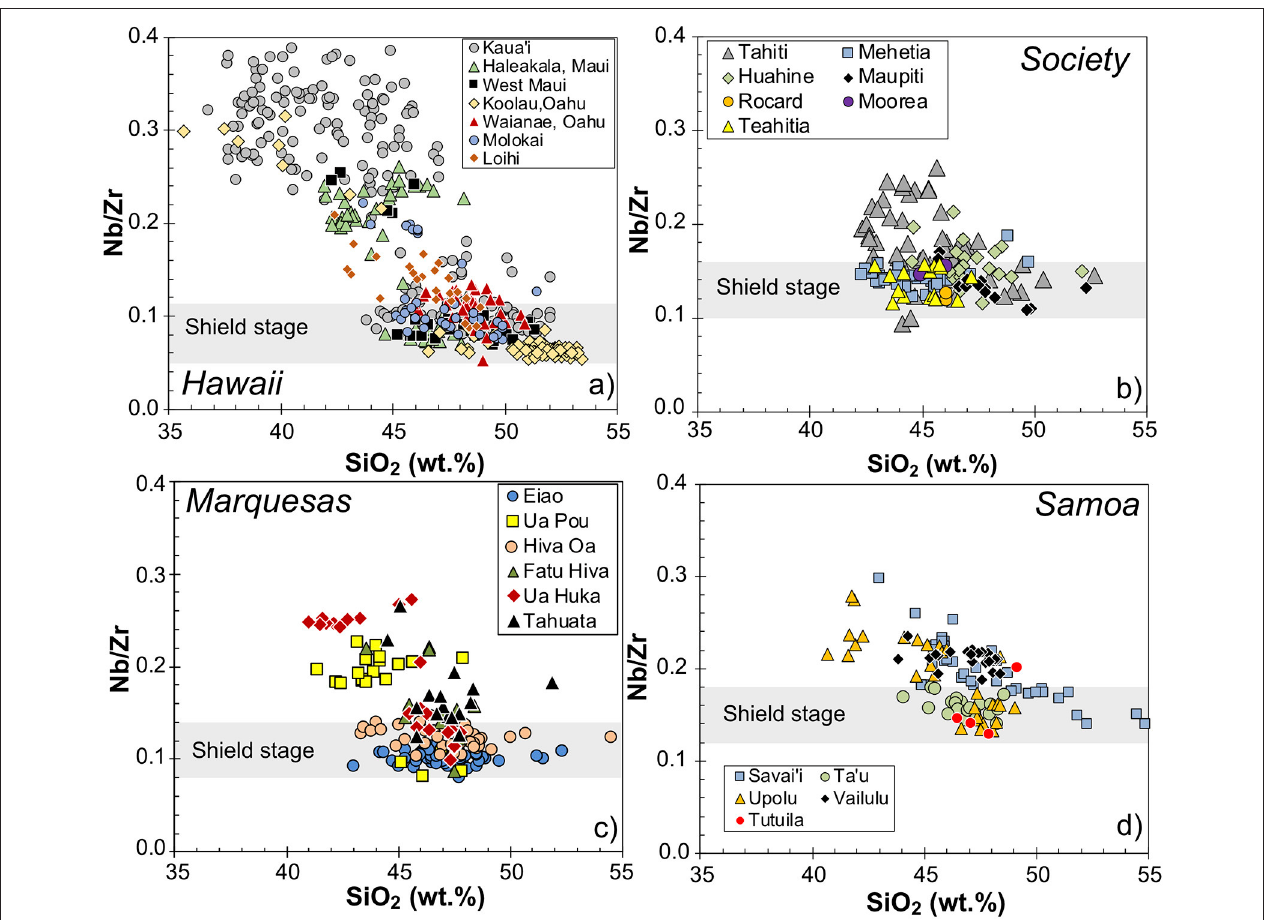
FIGURE 3 | The variation of Nb/Zr ratios with SiO 2 contents for the lavas from the (a) Hawaiian, (b) Society, (c) Marquesas, and (d) Samoa hotspots. The Nb/Zr ratio remains constant during much of the magma evolution and is generally not affected by fractional crystallization. The differences of Nb/Zr ratios in lavas from the same volcanoes reflect different magma series of volcanic stages. The lavas with the lowest Nb/Zr typically represent the shield stage as outlined by the gray bars. Data sources can be found in the Supplementary Material